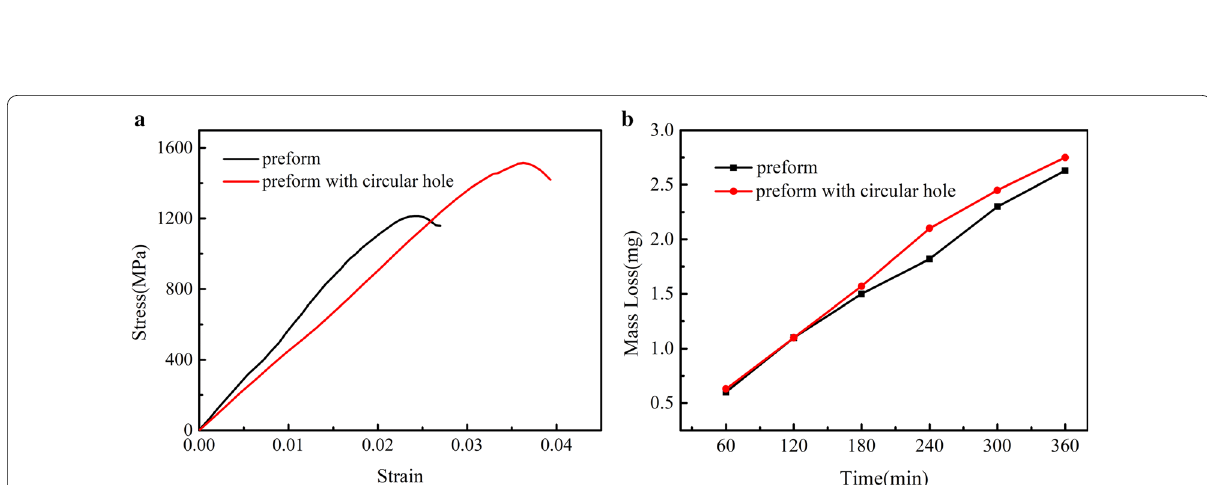
Fig. 9 Compression stress–strain curve of HCCI/ZTA P composite material and mass loss of three-body abrasive at the junction of composite honeycomb